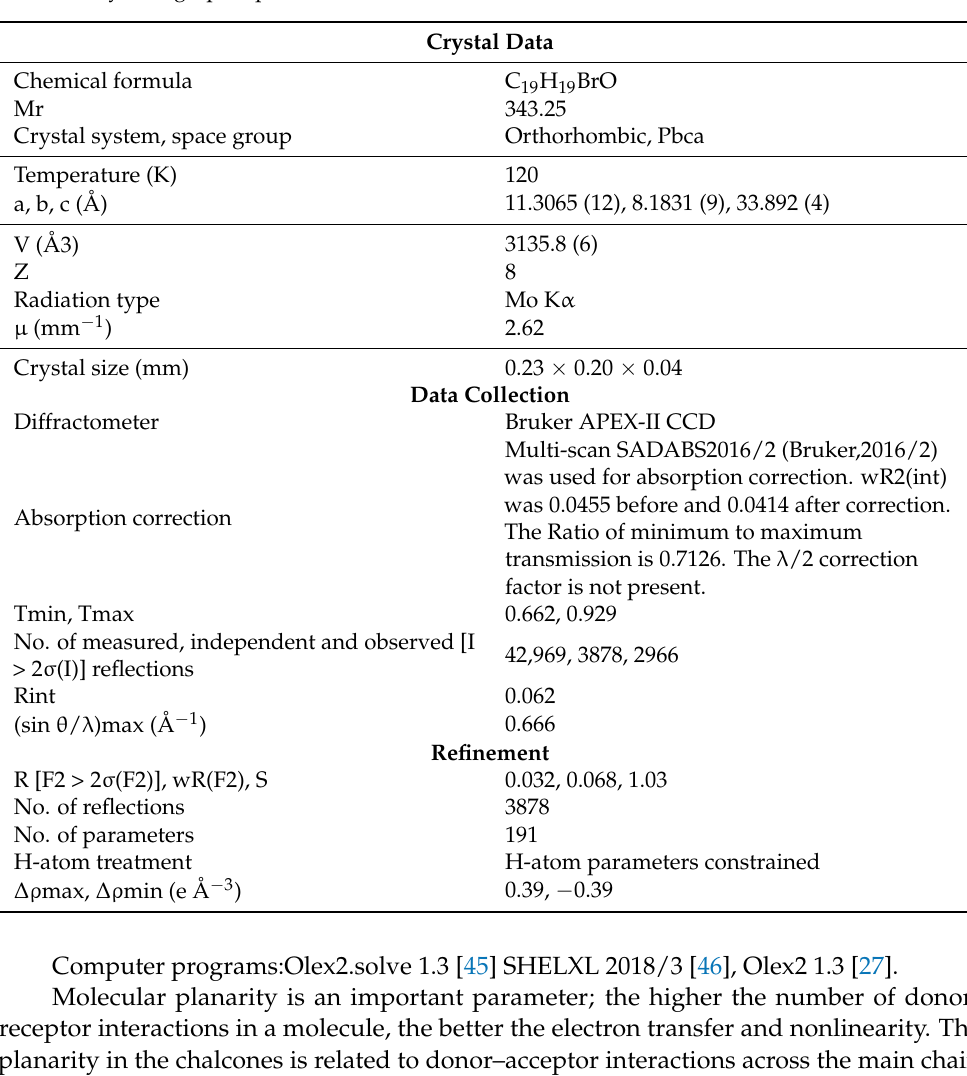
Figure 11. Illustration of the angles between rings for BRCHAL. The supramolecular arrangement of BPP is stabilized by C – H ⋯ O and the C — H ⋯ π . interactions, with donor – acceptor distances being shorter than the sum of the van der Waals radii (2.7 Å for O and H) [50]. The BPP crystal packing molecules in a layer along the a-axis are presented in Figure 8 and were responsible for joining the crystal by the C5 — H5 ⋯ O1 interaction (d/Å, θ/°: 2.67 Å, 148°), symmetry code , (i) x − 1/2, − y + 1/2, − z + 1, and was also stabilized by edge-to-face C12 — H12 ⋯ π interaction involving aromatic ring B, shown in Figure 12 [29]. This was confirmed by the shape index (I) that provides in- formation regarding π ⋯ π and C— H ⋯ π, and dnorm surface(II) , with C – H ⋯ O observed by the concave red region over aromatic ring B. Such interactions also explain the observed conformation of the molecular structure at BBP [25,27].